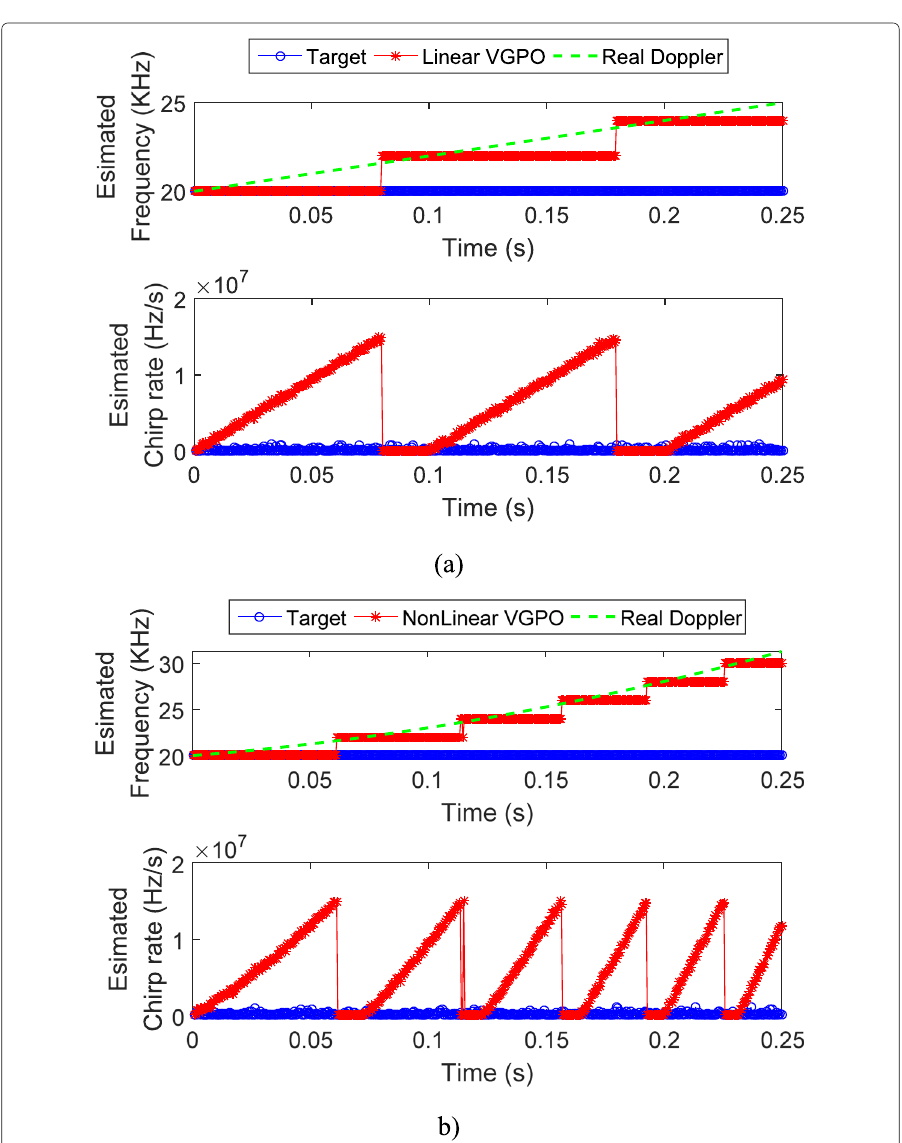
Fig. 3 The estimated frequencies and chirp rates of target echo and jamming signal versus time. a Linear scenario. b Non-linear